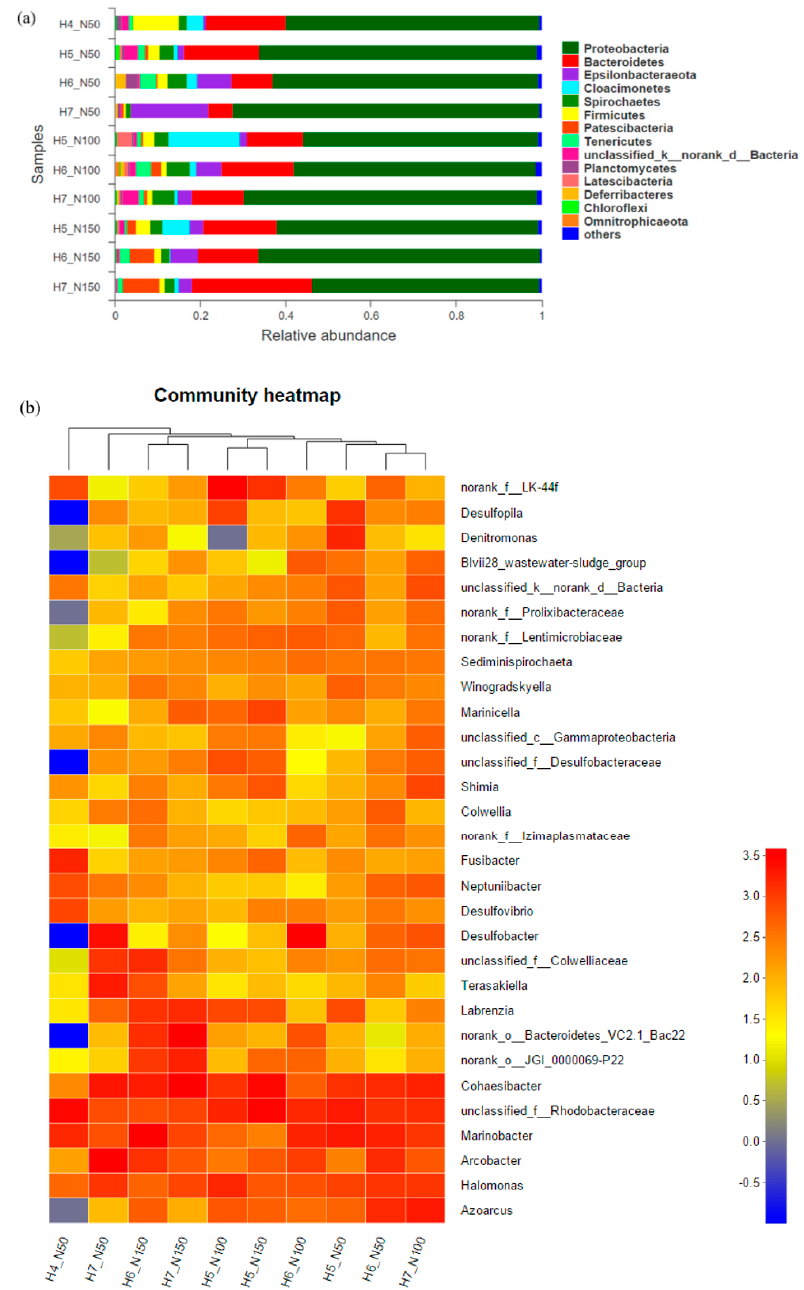
Figure 3. ( a ) Taxonomic classification of microbes at the phylum level within the biofilter in the respective experimental phases. ( b ) Heat map of the top 30 genera in each phase, representing the relative abundance and distribution of the representative 16S rRNA sequences at the genus level. Heat map colors correspond with the relative abundance of each phylogenetic group, ranging from blue (low abundance), to yellow, to red (high abundance).